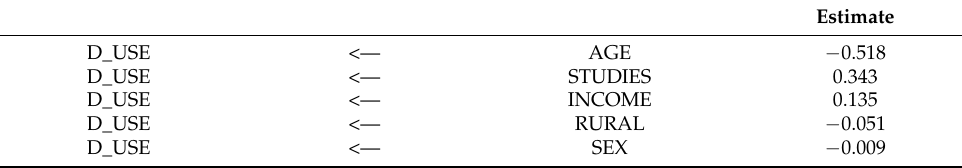
Table A2. Standardized Regression Weights: (Group number 1-Default model).